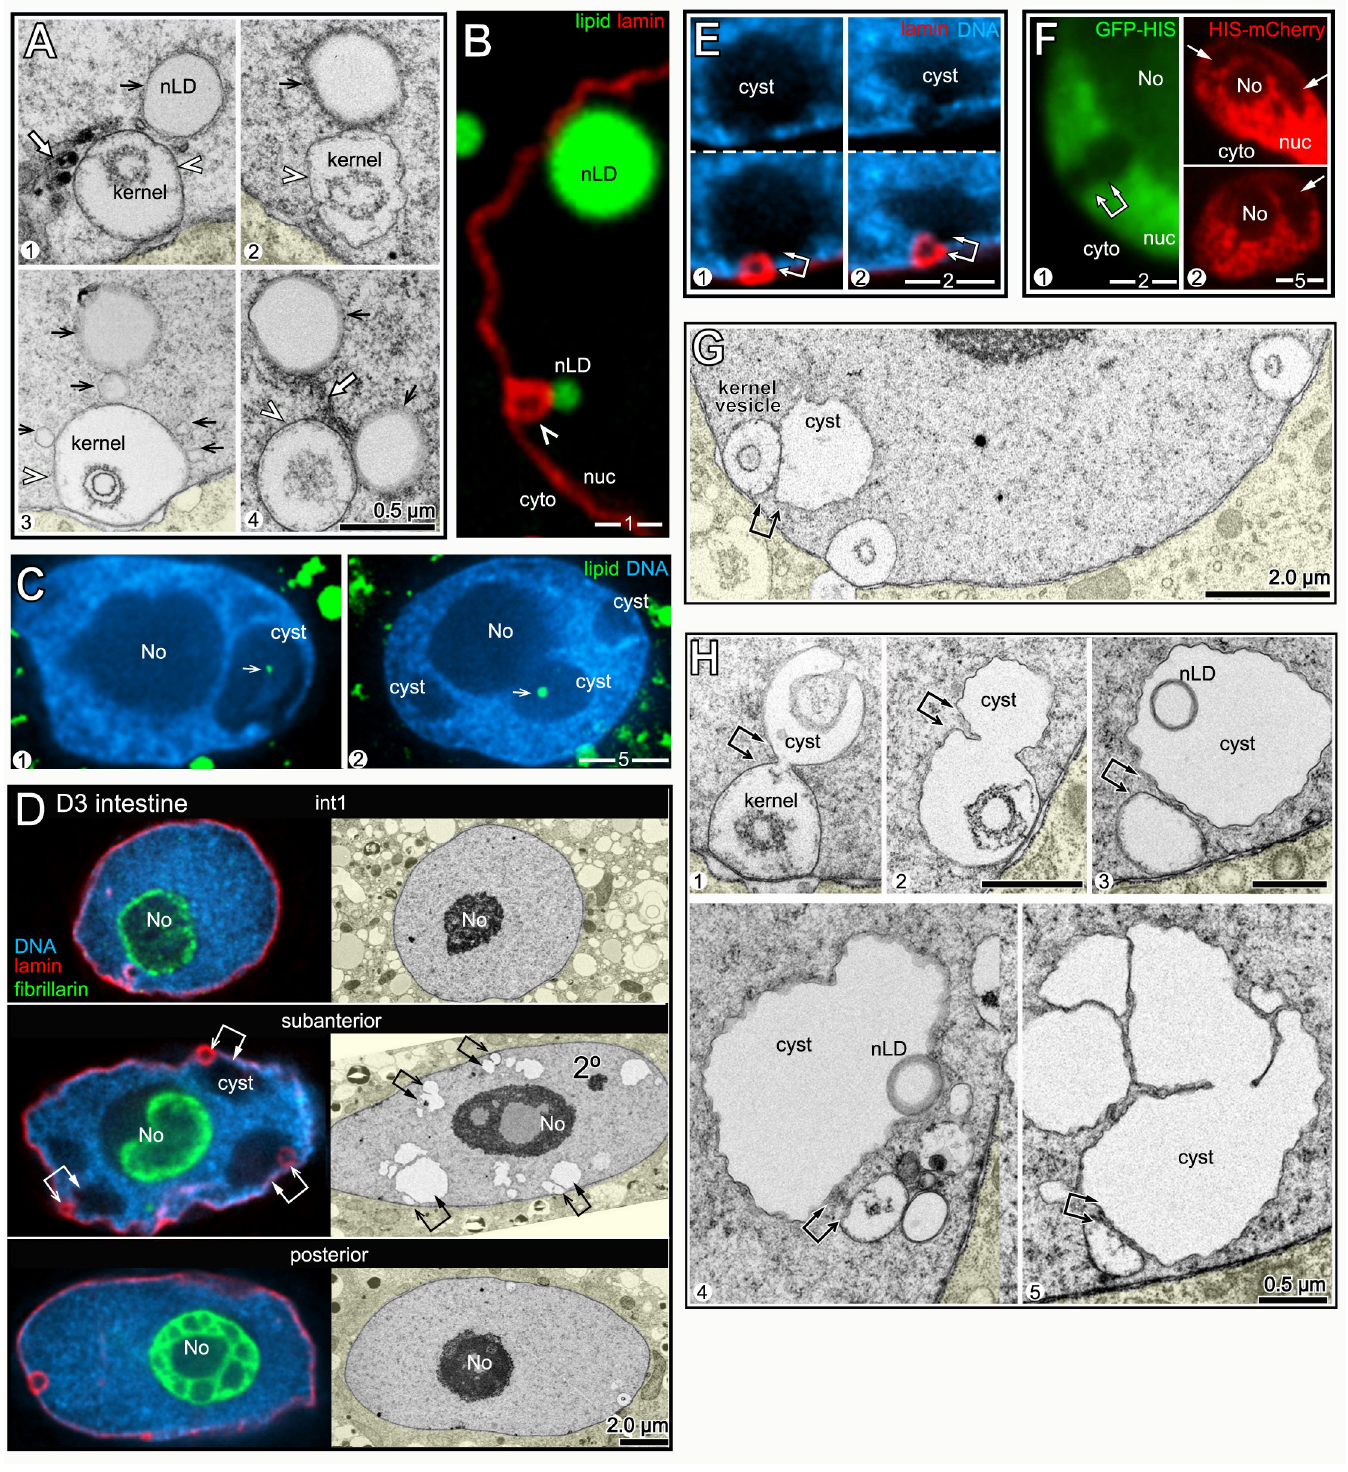
Fig 7. nLDs and nucleoplasmic cysts. (A) TEM images of nLDs (black arrows) at the perimeter of kernel vesicles (arrowheads). Note that there are five nLDs around the kernel vesicle in panel 3. Note also nuclear tubules in panels 1 and 4 (white arrows). (B) D2 nucleus with two nLDs, one at the perimeter of a lamin sac (arrowhead) as in Fig 7A . (C) Examples of D3 nuclei with small nLDs (arrows) inside large nucleoplasmic cavities or cysts. (D) Immunostained (left column) and TEM images (right column) of D3 nuclei from the indicated regions of the intestine. Large nucleoplasmic cysts are visible in the subanterior nuclei, but not in the flanking nuclei (see also S5